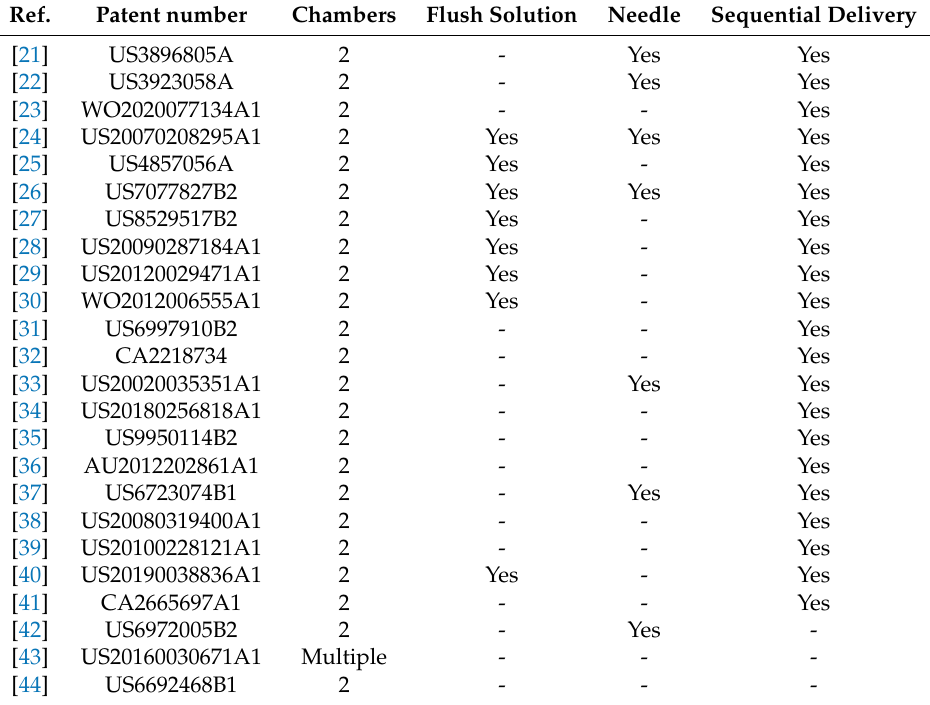
Table 1. Main characteristics of the double-chamber syringes (DCS) included for review. Ref. Patent number Chambers Flush Solution Needle Sequential